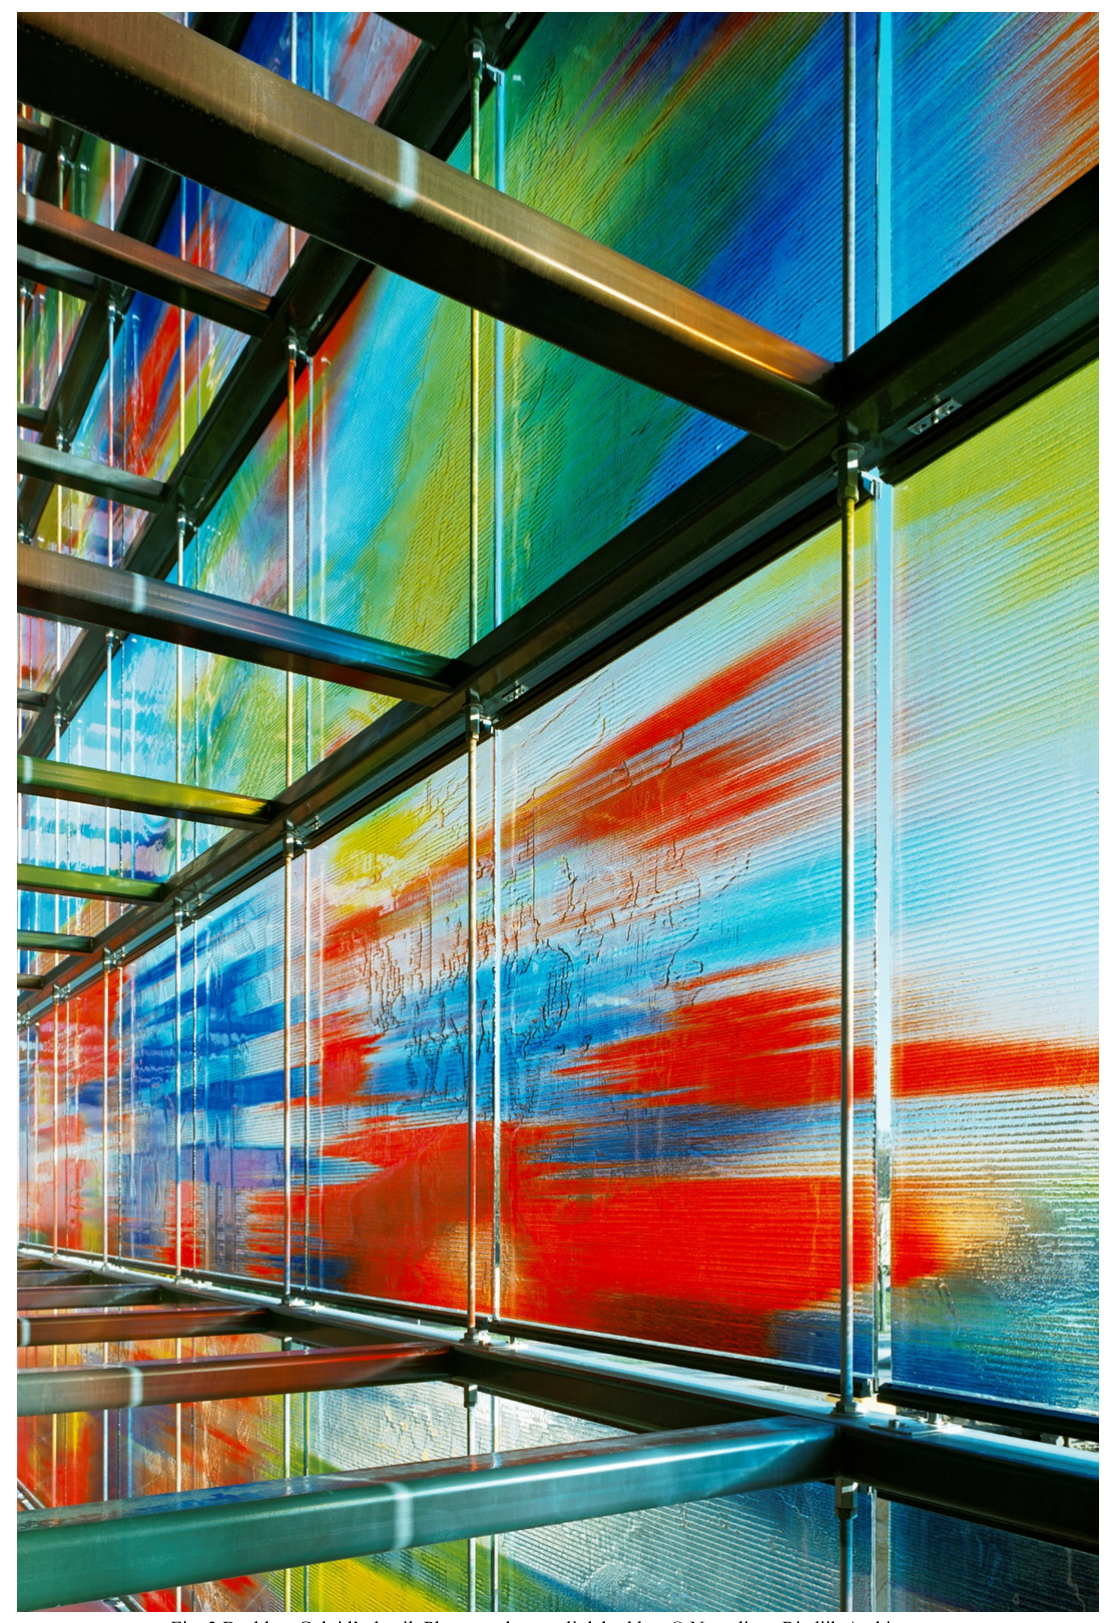
Fig. 3 Beeld en Geluid’, detail. Photography scagliolabrakkee © Neutelings Riedijk